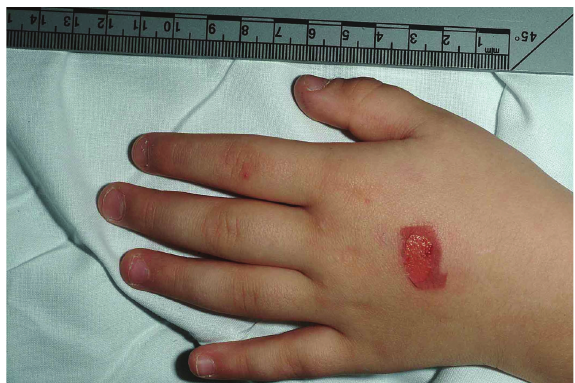
Figure 1: Salbutamol inhaler-induced burn (left hand).